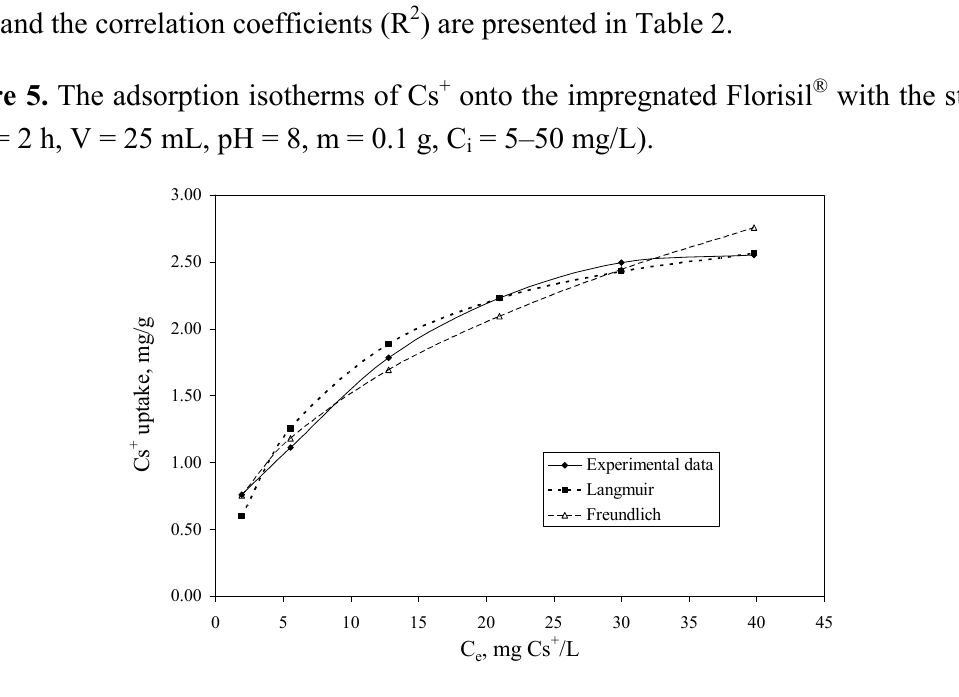
Figure 5. The adsorption isotherms of Cs + onto the impregnated Florisil ® with the studied IL (t = 2 h, V = 25 mL, pH = 8, m = 0.1 g, C